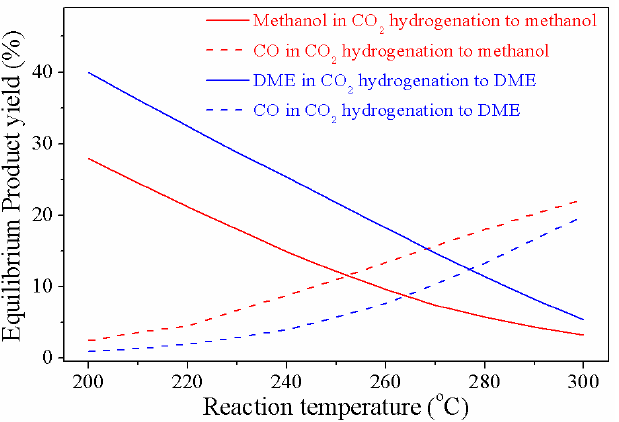
Figure 2. Equilibrium product yield in the CO 2 hydrogenation. Reproduced with permission from Shen et al. [35], published by Springer Nature, 2000.